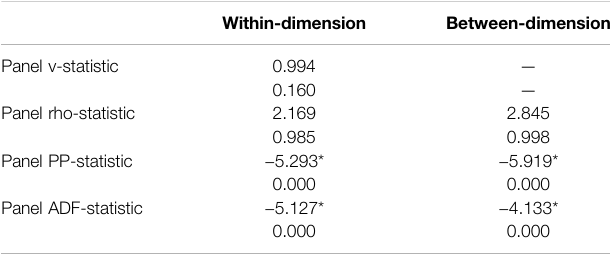
TABLE 3 | Cointegration